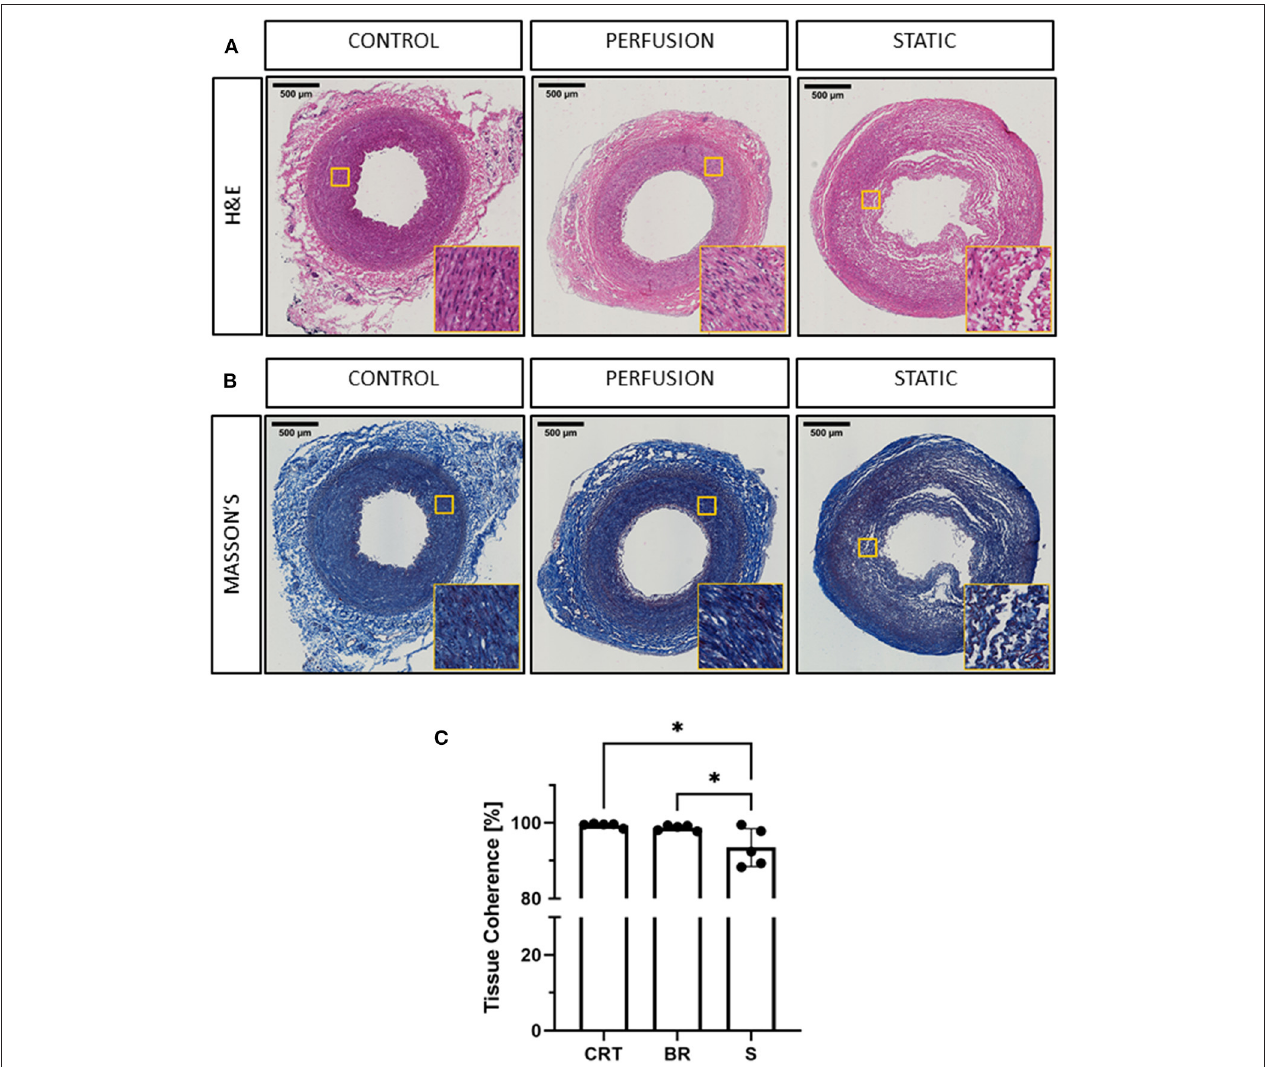
FIGURE 2 | Histological evaluation of porcine carotid arteries cultured in EasyFlow or static conditions. Hematoxylin and Eosin staining H&E (A) and Masson’s Trichomic staining MASSON’S, (B) of freshly isolated carotid artery tissue (CONTROL) and samples cultured for 7 days in EasyFlow (PERFUSION) or static culture (STATIC). Scale bars = 500 µ m. Quantification of tissue coherence is displayed in the bar graph (C) , n = 5. All data are mean ± SD. One-Way ANOVA analysis was performed, * p ≤